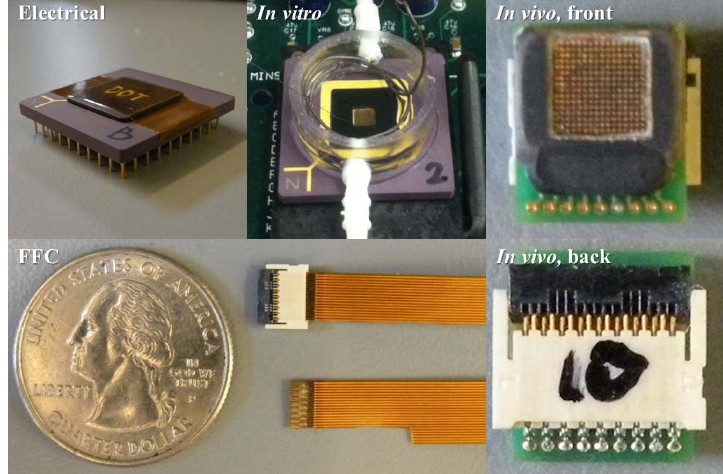
Figure 7. Chip packaging: A standard 10 × 10 ceramic PGA ( Top left ), an open-top 10 × 10 ceramic PGA ( Top middle ), front side of the custom printed circuit board (PCB) package ( Top right ), back side of the custom PCB package ( Bottom right ), and flat flexible cables (FFC) ( Bottom middle ).